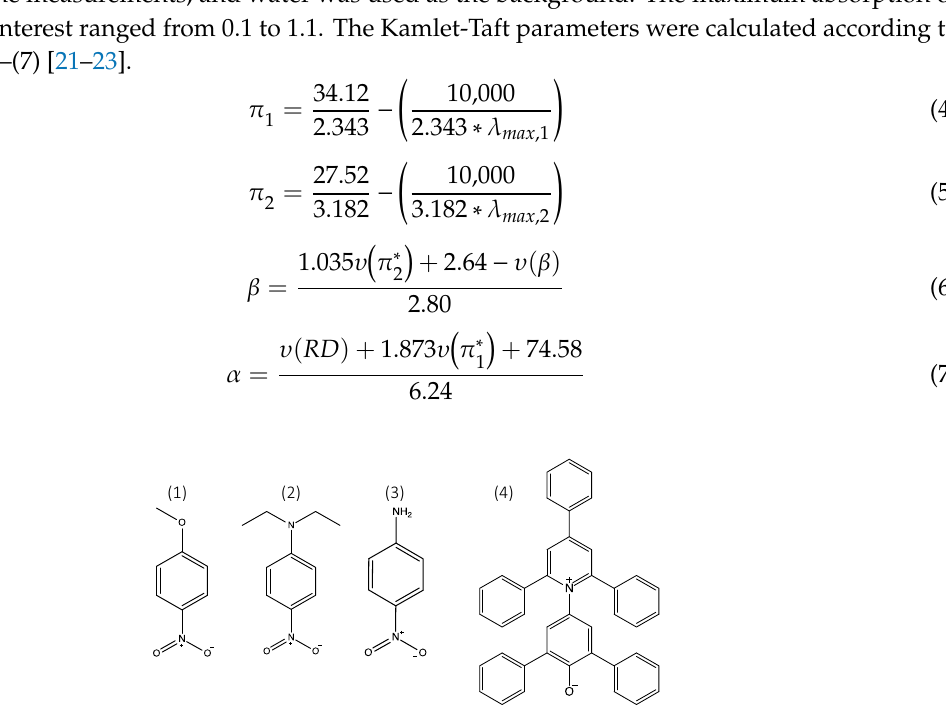
Figure 2. The structures of the solvatochromic dyes: ( 1 ) 4 ‐ nitroanisole; ( 2 ) N,N ‐ diethyl ‐ 4 ‐ nitroaniline; ( 3 ) 4 ‐ nitroaniline; ( 4 ) Reichardt’s dye.